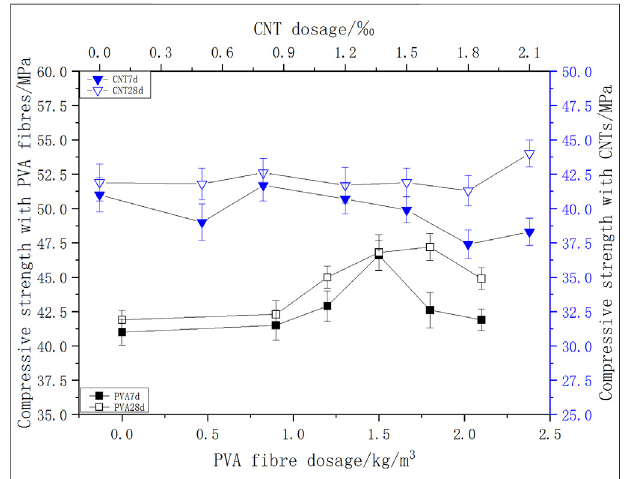
Frontiers in Materials |